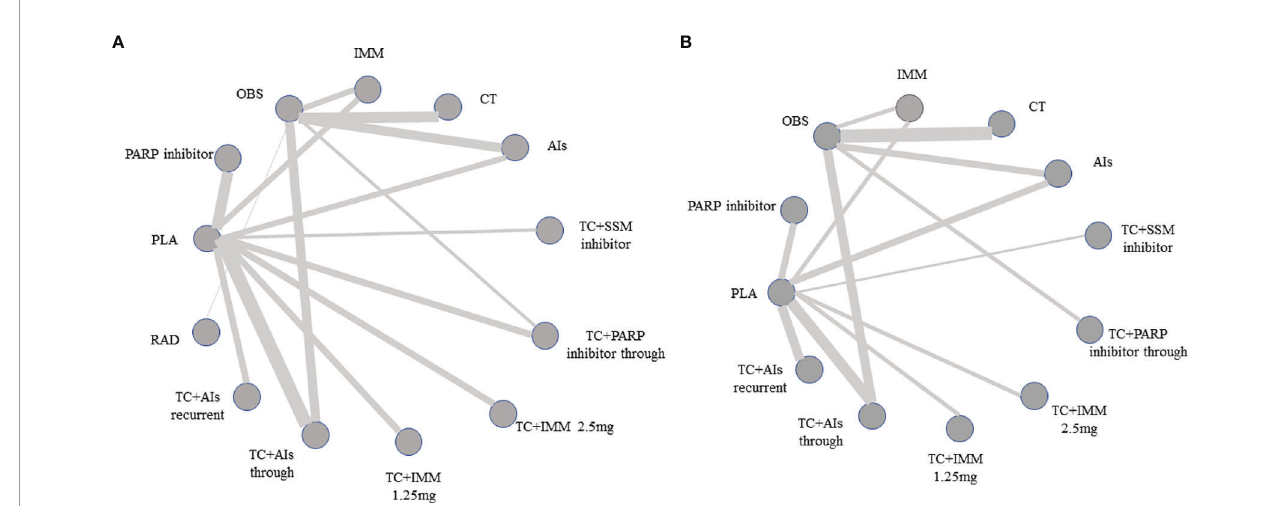
FIGURE 3 | Network of treatment comparisons for overall ef fi cacy. (A) Network plot of treatment comparisons of progression-free survival. (B) Network of treatment comparisons of overall survival. Directly comparable treatments are linked with a line, the thickness of which corresponds to the number of trials that assessed the comparison. AIs, angiogenesis inhibitors; PLA, placebo; TC, platinum plus paclitaxel; CT, chemotherapy; OBS, observation; PARP inhibitors, poly (ADP-ribose) polymerase inhibitors; IMM, immunotherapy; RAD, radiotherapy; SSM inhibitors, selective small-module